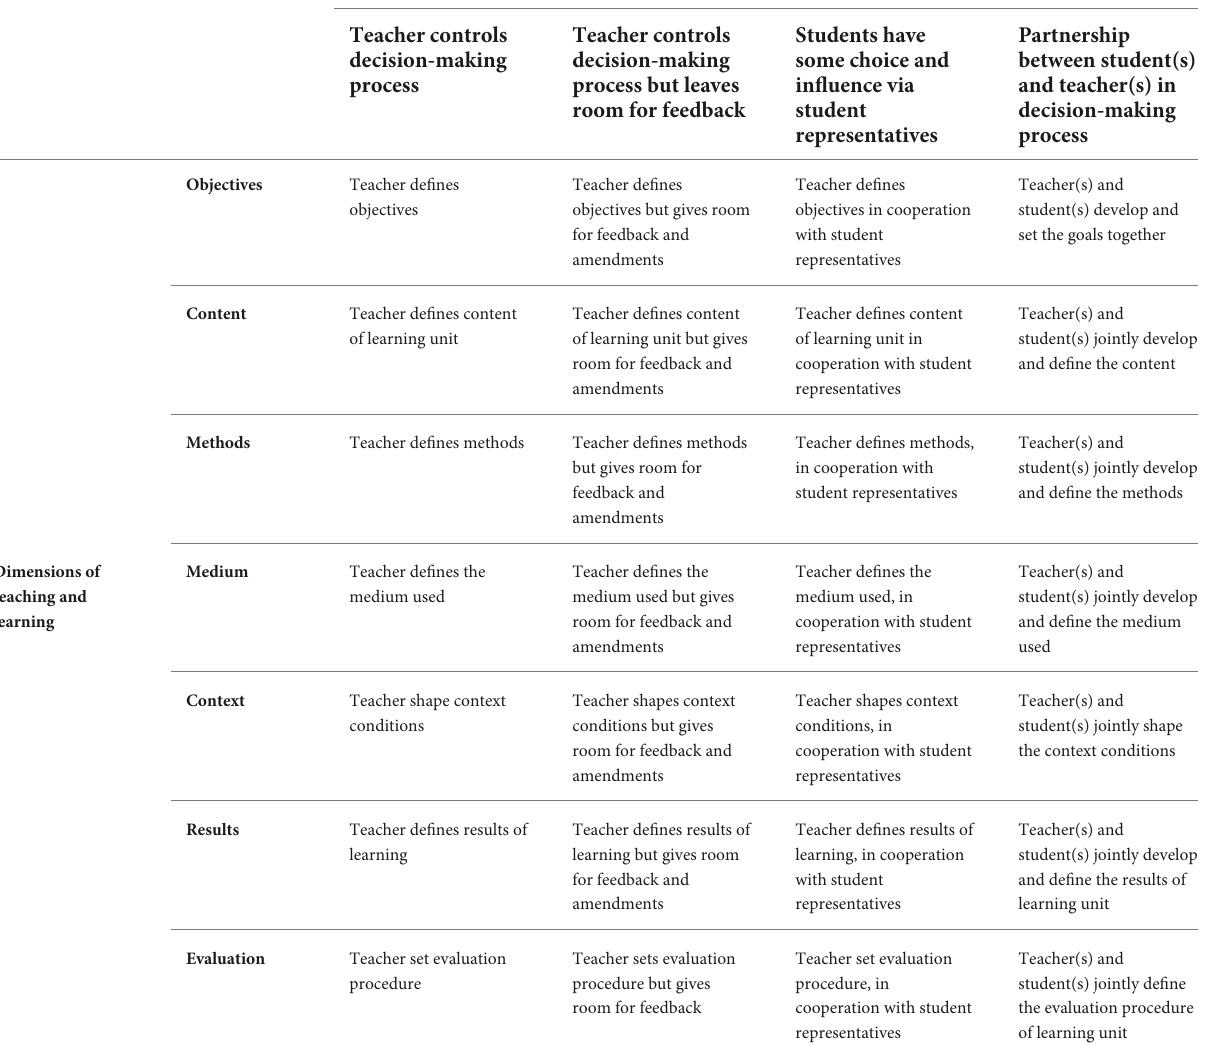
TABLE 5 Analytical framework for Participatory Educational Practices